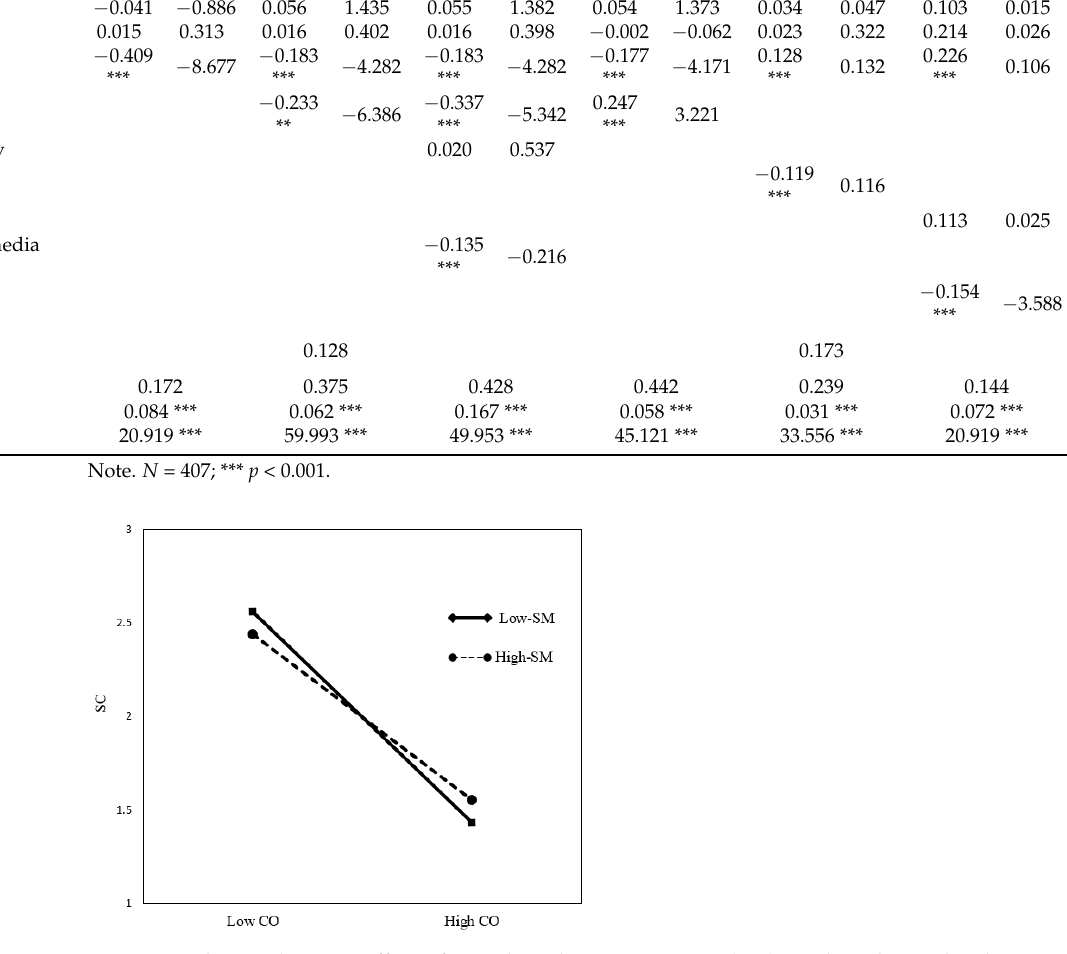
Figure 2. The Moderating effect of Social media use intensity (SM) on the relationship between Cyber-ostracism (CO) and Sense of control (SC).